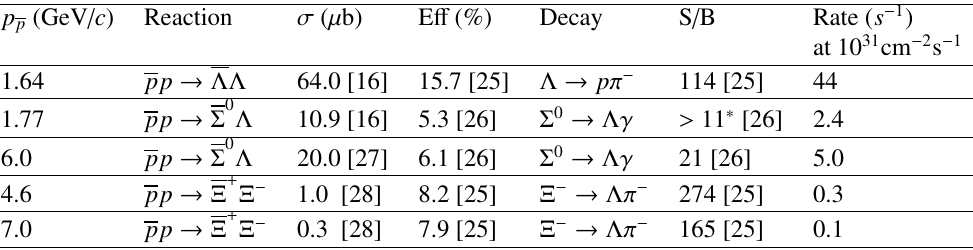
Table 1. Results from simulation studies of the various production reactions of ground state hyperons [25, 26]. The e ffi ciencies are for exclusive reconstruction, i.e. considering all final state particles. The S / B denotes signal-to-background ratio and the asterisk * the upper limit of a 90% confidence